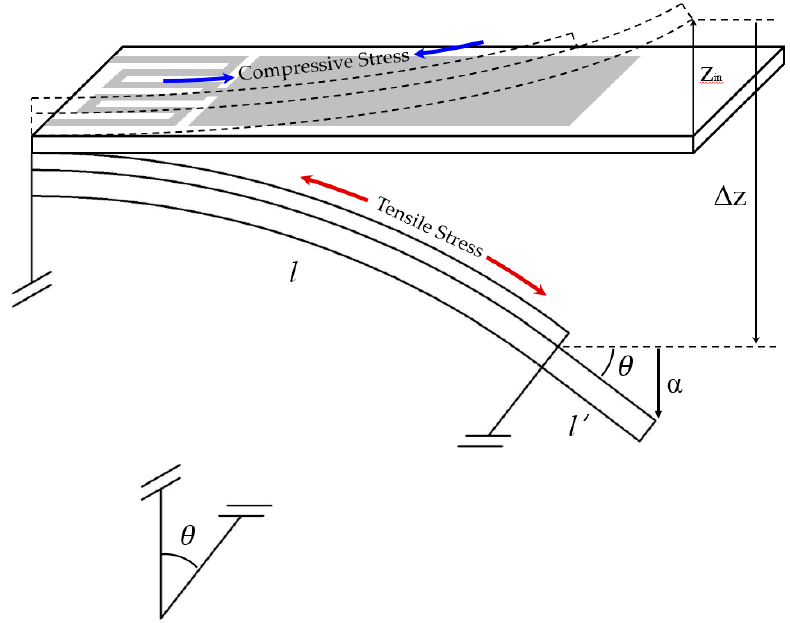
Figure 5. Geometrical representation of bending characteristics of thermal bimorph microcantilevers for theoretical calculation.